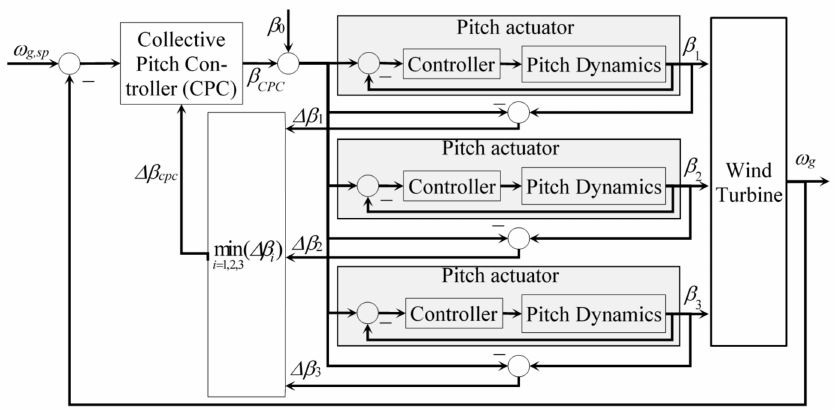
Figure 15. Anti-windup strategy for the collective pitch